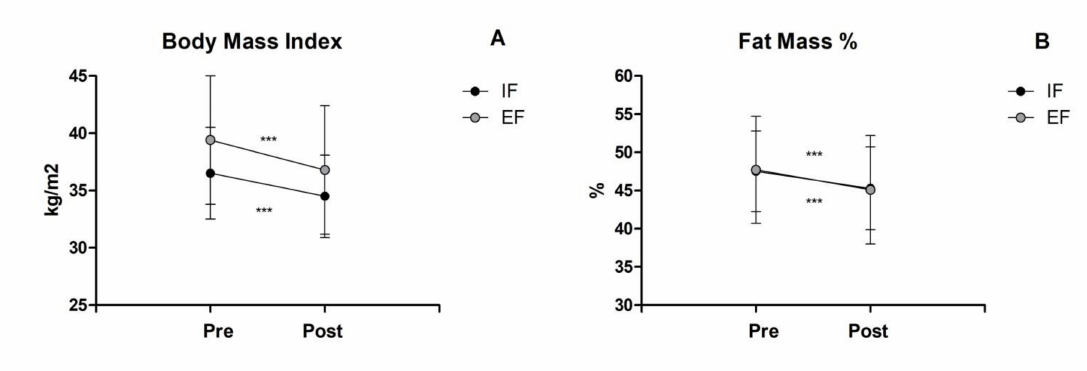
Figure 2. Anthropometric and body compositional parameters: ( A ) Body Mass Index, ( B ) Fat Mass percentage. *** Significant main effect of time before and after testing ( p <